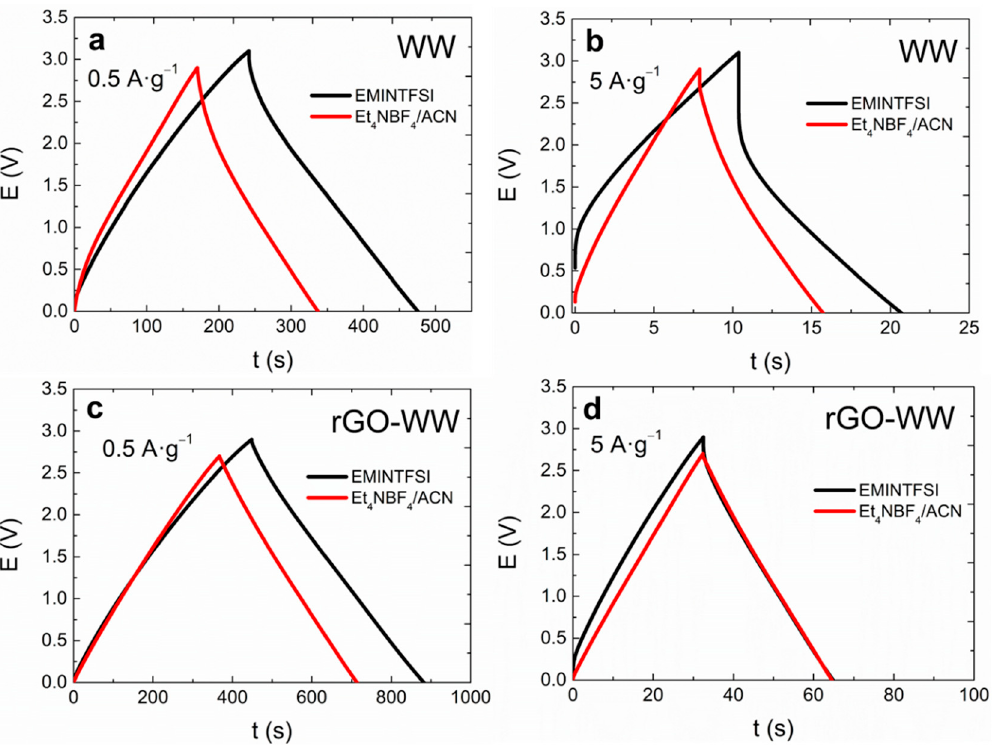
Figure 4. Galvanostatic charge-discharge curves registered in both electrolytes for WW sample at 0.5 ( a ) and 5 A · g − 1 ( b ); and corresponding measurements for rGO-WW ( c , d ). Table 2. Physical properties of the selected electrolytes.